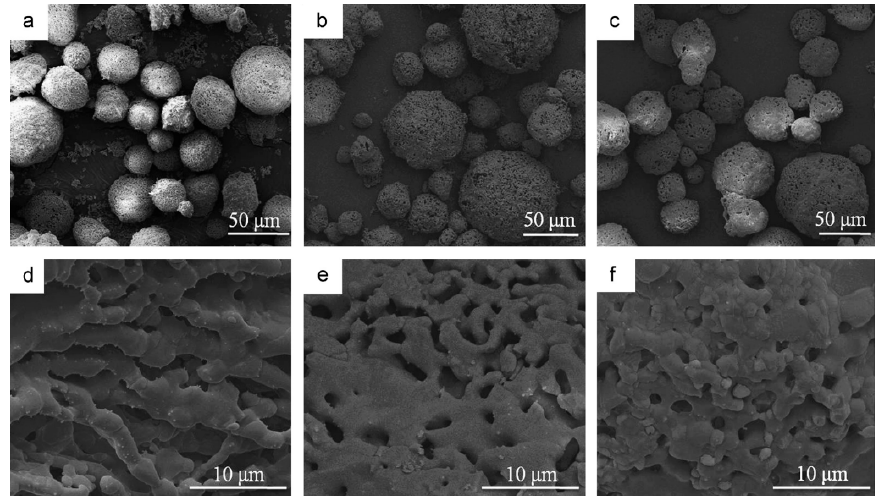
Figure 3. SEM micrographs of porous HA microspheres fabricated from suspensions with different PVA contents, ( a , d ) 0.5 wt%, ( b , e ) 1.0 wt%, and ( c , f ) 1.5 wt%. ( d – f ) at low and high